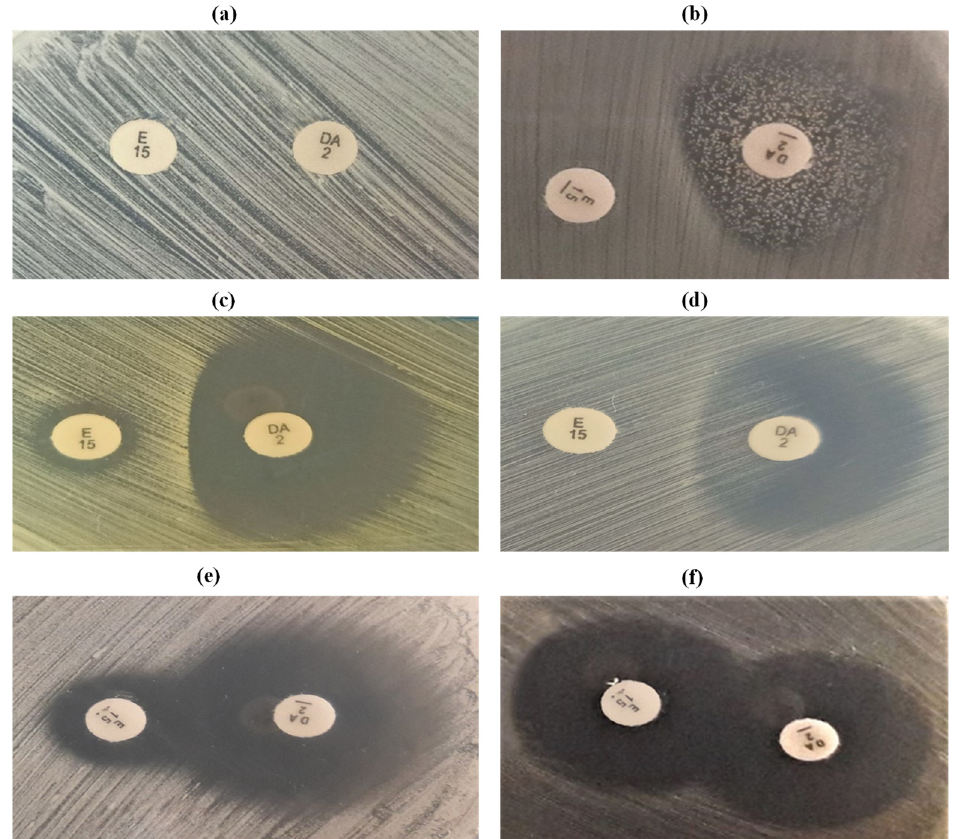
Figure 3. MLS B phenotypes. ( a ) Isolate no. 47; R phenotype of constitutive MLS B (cMLS B ) in tested S. aureus isolates, resistant to both clindamycin and erythromycin. ( b ) Isolate no. 12; HD phenotype of cMLS B in tested S. aureus , with two zones of growth around clindamycin disk, one zone with a light hazy growth up to clindamycin disk, and the second zone with heavy growth, showing D zone. ( c ) Isolate no. 10; D phenotype of inducible MLS B (iMLS B ), with a clear D zone around clindamycin disk. ( d ) Isolate no. 15; D + phenotype of iMLS B , which revealed a D-shaped zone with small colonies growing towards the clindamycin disk inside the D zone. ( e ) Isolate no. 36; MS phenotype in tested S. aureus isolates that showed resistance to erythromycin and susceptibility to clindamycin without any D zone. ( f ) Isolate no. 27; S phenotype, sensitive to both clindamycin and erythromycin.